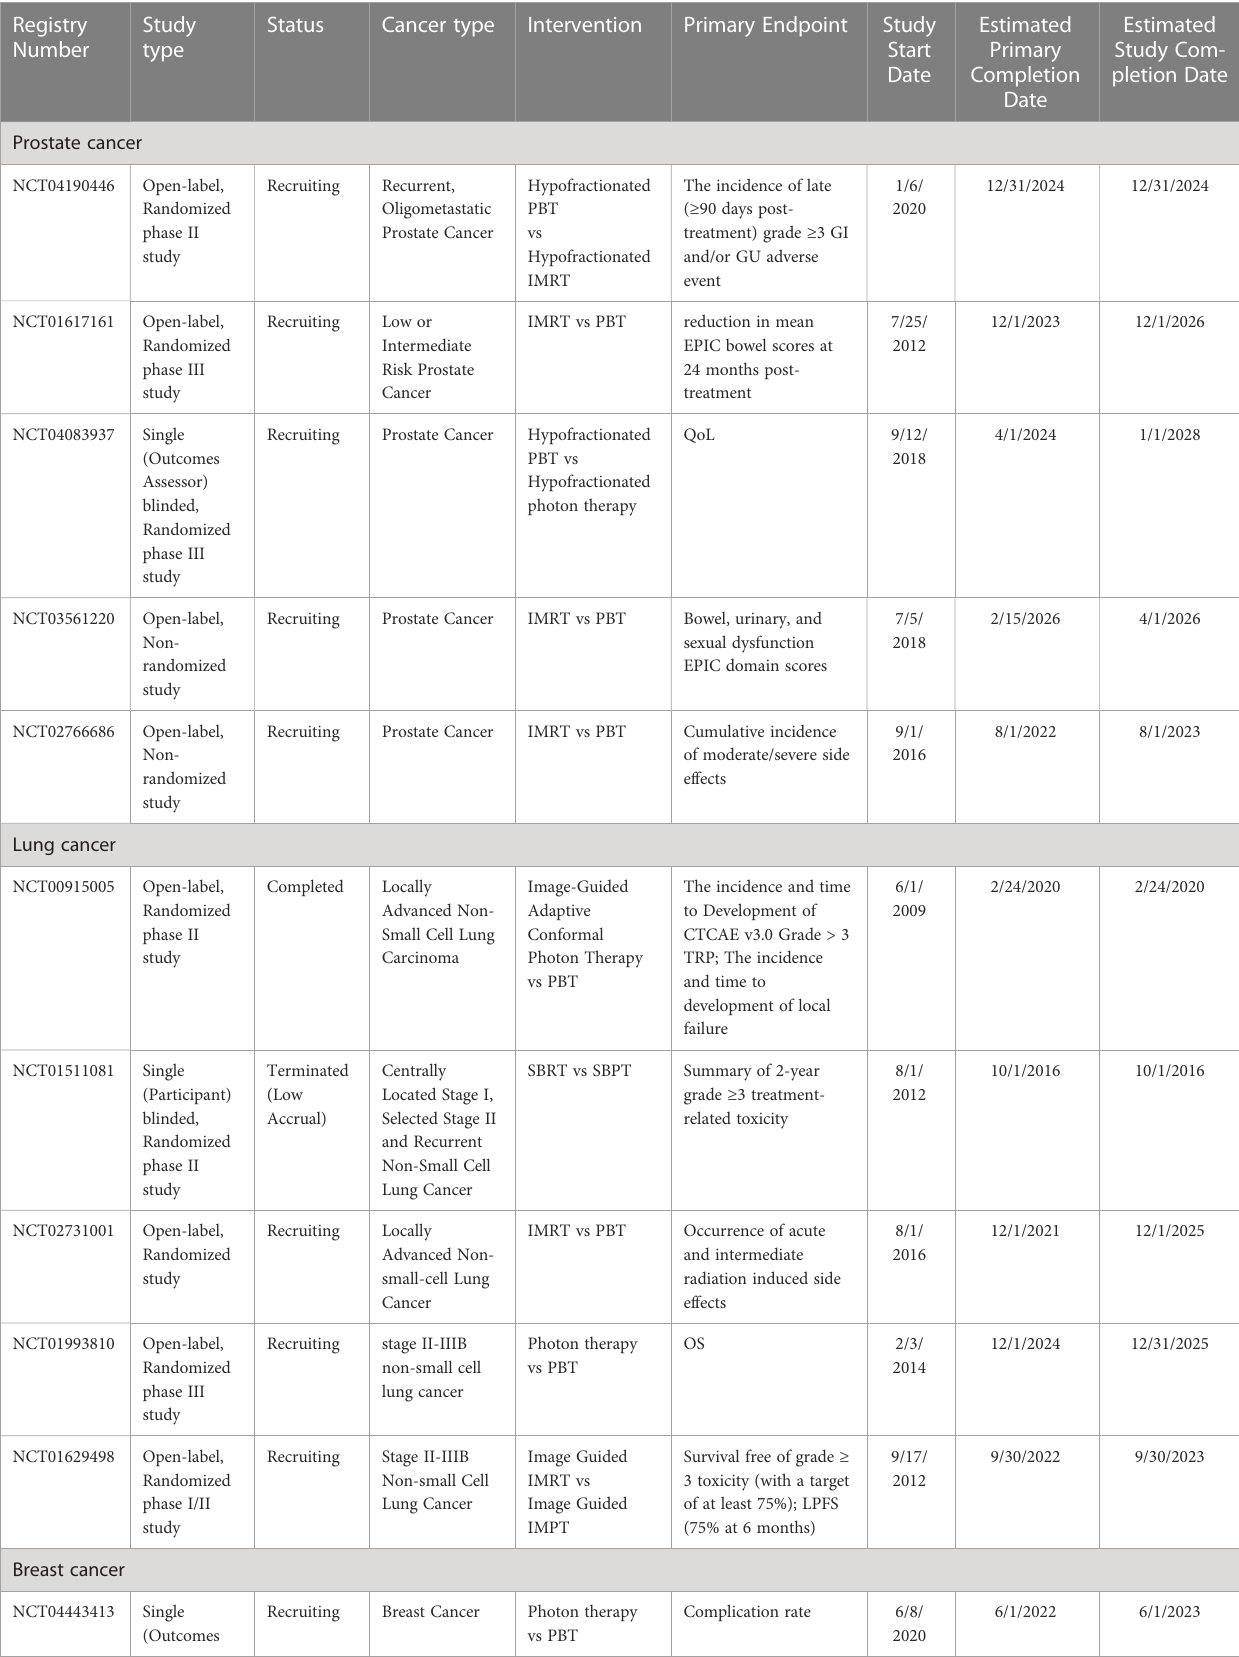
TABLE 9 Non-randomized and randomized clinical trials of proton versus photon radiation therapy (see